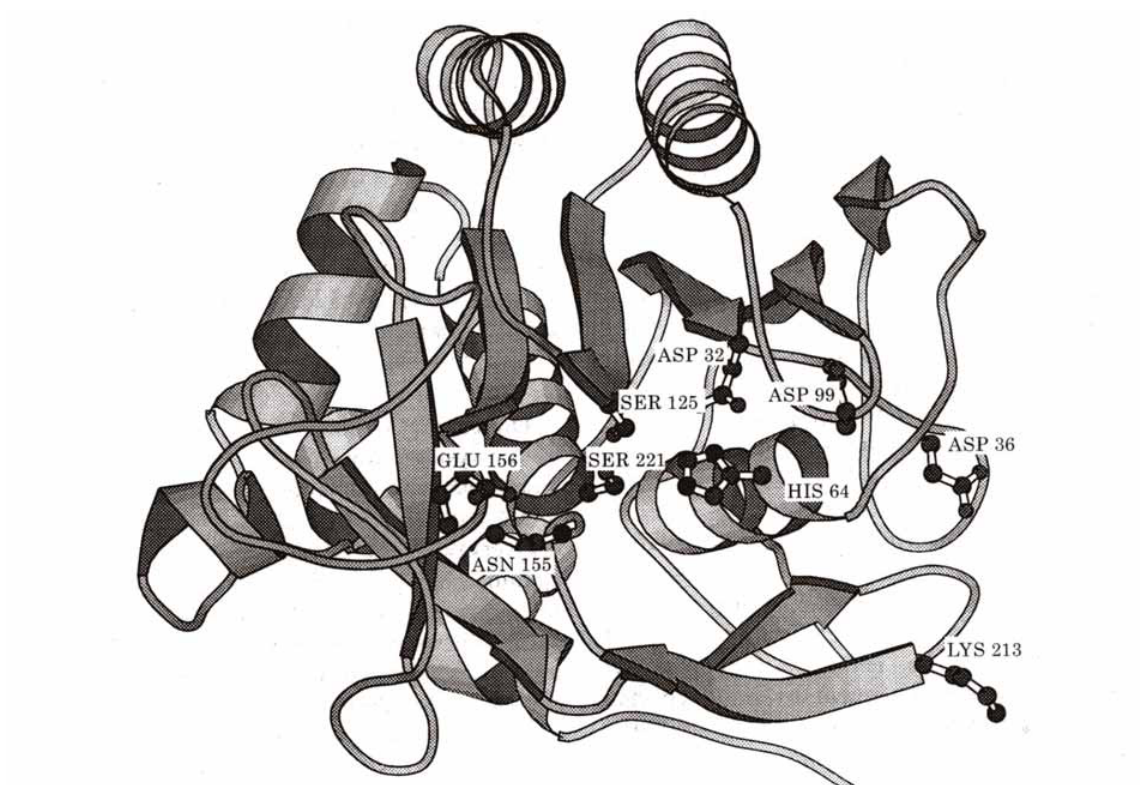
Figure 16. Schematic drawing of subtilisin. Side chains of the residues of importance in the discussion are shown explicitely (Reprinted with permission by Academic Press, Reference [107]).